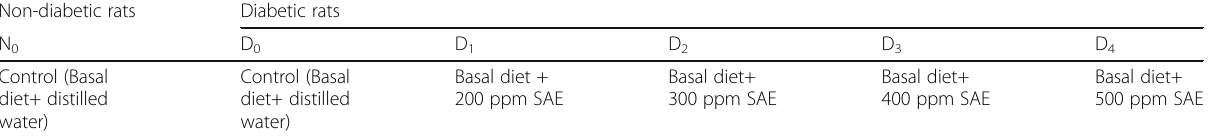
Table 1 Addition of aqueous Stevia extract in the distilled water of rats at different substitution levels Non-diabetic